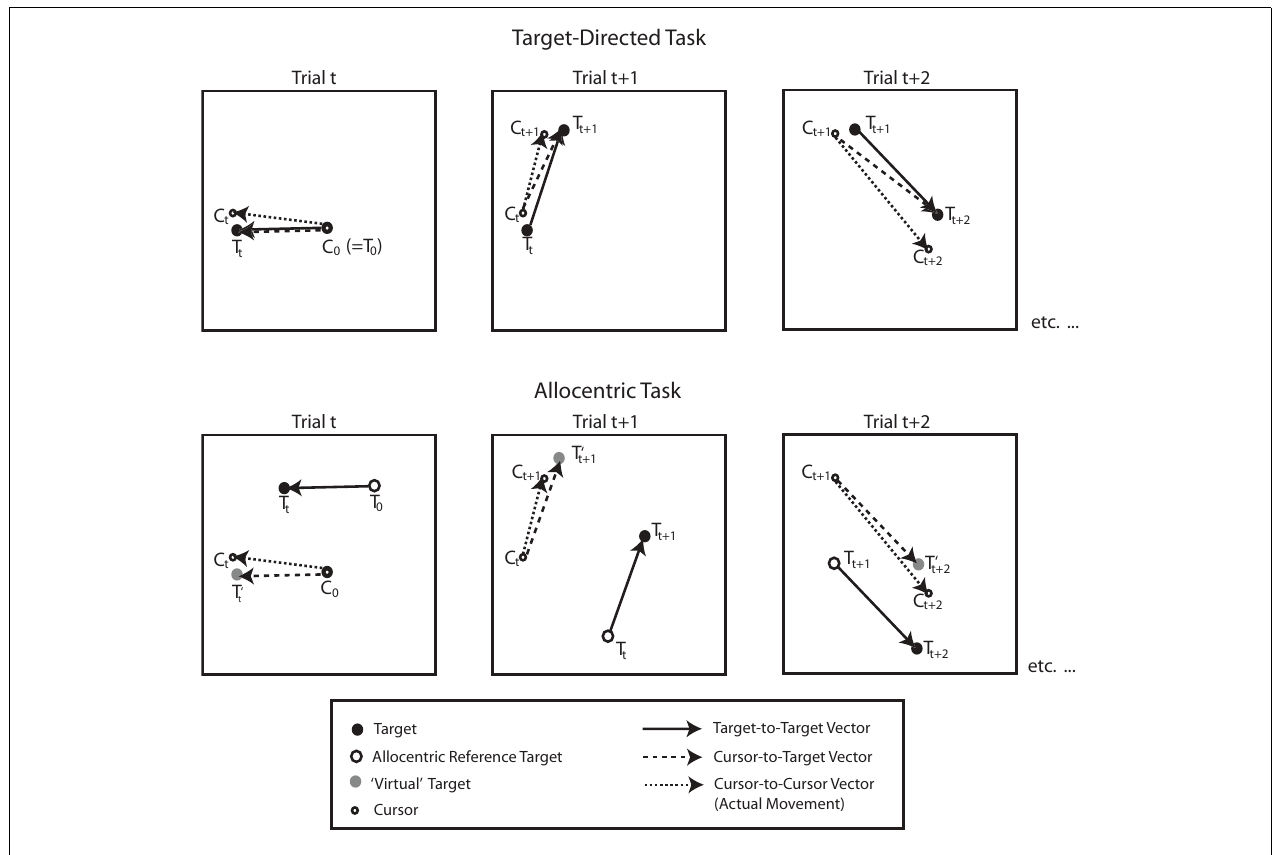
FIGURE 4 | Illustration of the vectors computed in the context of behavioral data analyses for target-directed and allocentric tasks. Capital C andT refer to the position of the cursor and target, respectively. Subscripts refer to trial numbers. C 0 denotes the starting point of the cursor in the beginning of a block.T 0 denotes the starting target, or starting reference